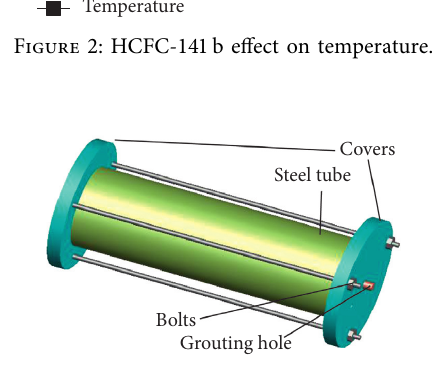
Figure 3: Specimen mould.